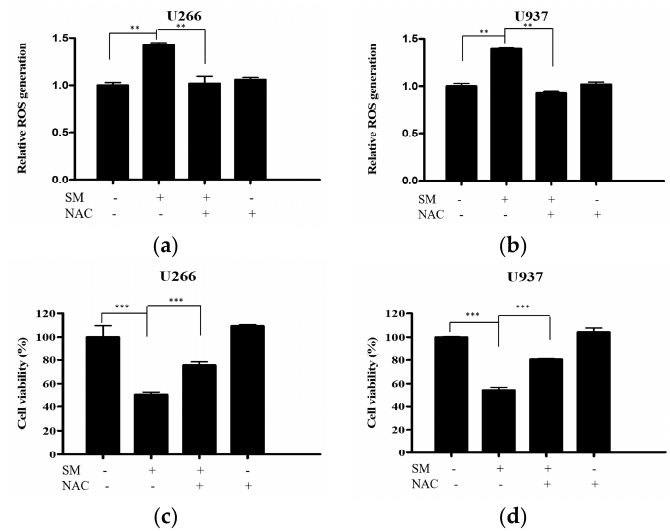
Figure 2. SM increases reactive oxygen species (ROS) production and ROS is required for an SM- induced cytotoxic effect on U266 and U937 cells. ( a ) U266 cells were treated with SM (50 µg/mL) for 24 h with or without pre-treatment of NAC (5 mM) for 1 h. ROS production was analyzed using a 2 ′ ,7 ′ -dichlorofluorescin diacetate (DCFDA) ROS detection assay kit. Values represent the means of three experiments ± SD; **, p < 0.01 versus the SM-only treated group; ( b ) U937 cells were processed under the same conditions; ( c ) U266 cells were treated with SM (50 µg/mL) for 24 h with or without pre- treatment of NAC (5 mM) for 1 h. Cell viability was determined by an EZ-cytox enhanced cell viability assay kit; ( d ) U937 cells were processed under the same conditions. Values represent the means of three experiments ± SD; ***, p < 0.001 versus an SM-only treated control.